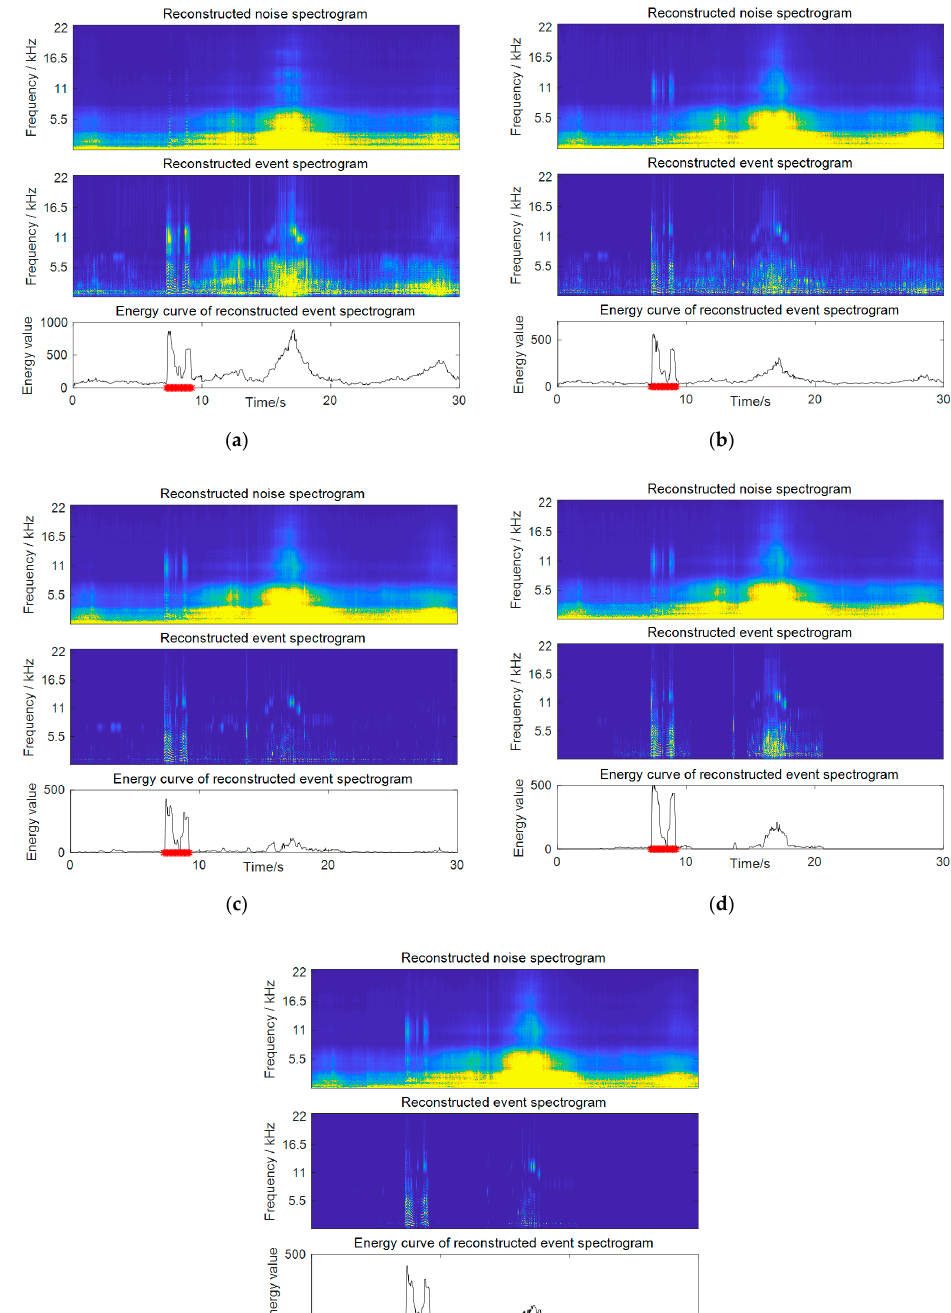
Figure 6. Detection results of the proposed weighted methods compared to two baseline approaches. The test noisy signal is shown in Figure 3a. ( a ) Results of the semi-supervised NMF approach; ( b ) results of the supervised NMF approach with noise dictionary learning, but without weighting. Results of the proposed supervised and weighted NMF approach with ( c ) frequency weighting, ( d ) temporal weighting, and ( e ) time-frequency weighting.